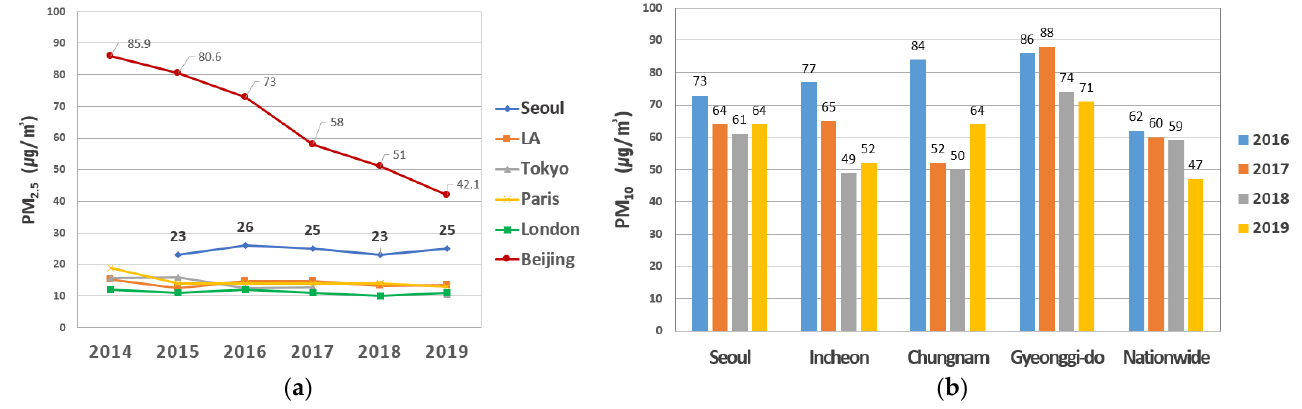
Figure 1. ( a ) Annual ultrafine-dust (PM2.5) concentration in the major cities of the world [4]; ( b ) annual fine-dust (PM10) concentration in Korea [4].